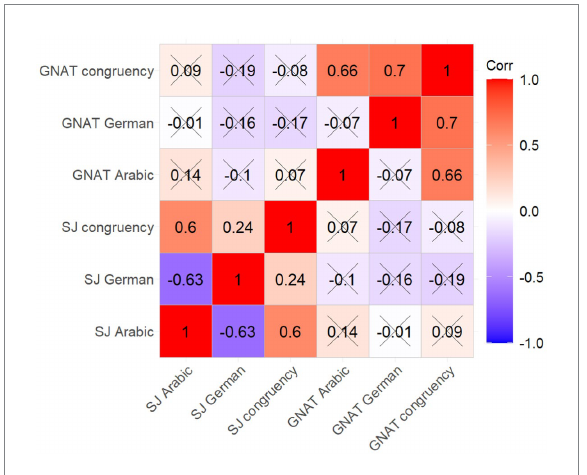
FIGURE 4 Correlations between congruency variables. Values in each cell represent correlation coefficients. Color coding denotes the direction of the correlation (see legend). Crosses indicate non- significant correlations ( p >